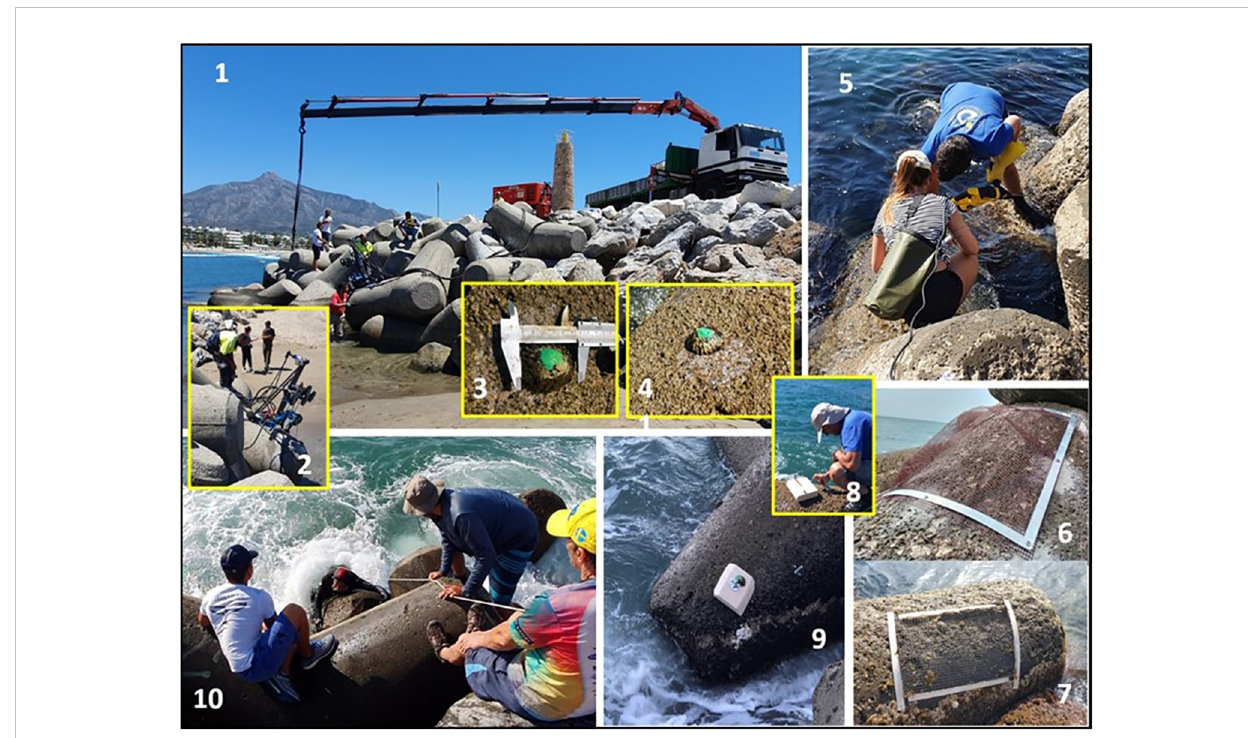
FIGURE 3 1 and 2: Preliminary tests of concrete tetrapod transfers and cutting of tetrapod arm sections with diamond head cutter, which re fl ected their technical infeasibility; 3: limpet marked with epoxy resin stamped with speci fi c code; 4: limpet placed on a small previously defaunated surface (descaled from barnacle Chthamalus stellatus ) to facilitate its new healing and sealing; 5: opening holes in the arm of a tetrapod, with a 1,200 watt hammer drill; 6: discarded prototype plastic cage and aluminum attachment strips, initially tested at P2, to test its wave resistance; 7: all-metal, stainless steel, wave-resistant cage design successfully used at P2; 8 and 9: intermediate attachment plates for extracted limpets, discarded at the beginning of P1A, were replaced with soft plastic “ zip-lock ” bags (see text); 10: time of extraction of specimens in heavy surf at the PJB